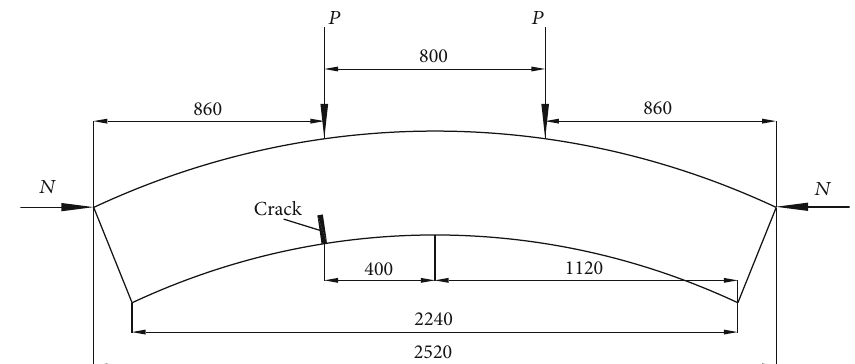
Figure 6: Schematic diagram of the loaded specimen (unit: mm).